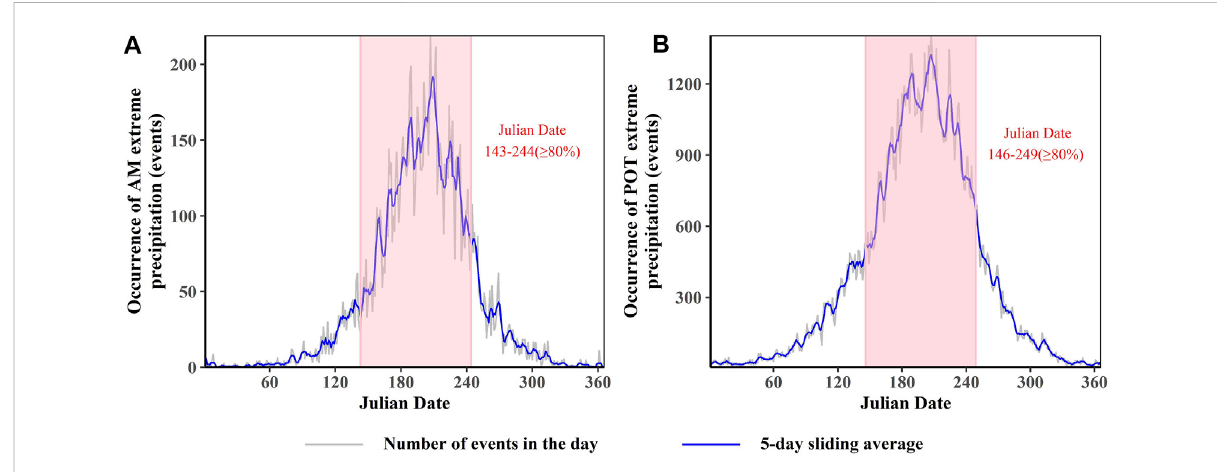
FIGURE 7 Intra-annual distribution of extreme precipitation events obtained from annual maximum (AM; (A) and POT sampling (B)